Question: Provide a one-line summary of what is displayed.
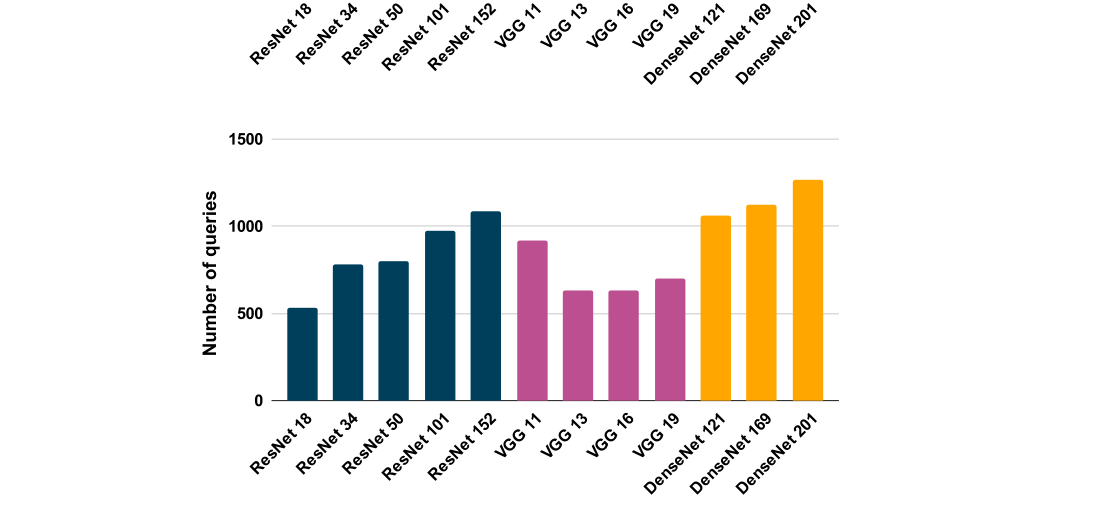
Answer: The amount of noise and time needed (green line) for MGAAttack to succeed against various models. As the number of layers increases, the attack success rate decreases (above), and the number of queries increases (below).